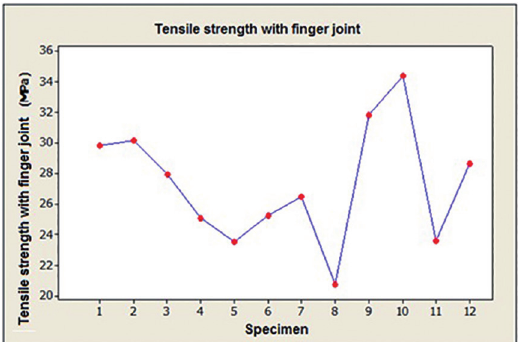
Figure 6: Chart showing tensile strength values for sample with finger joints.